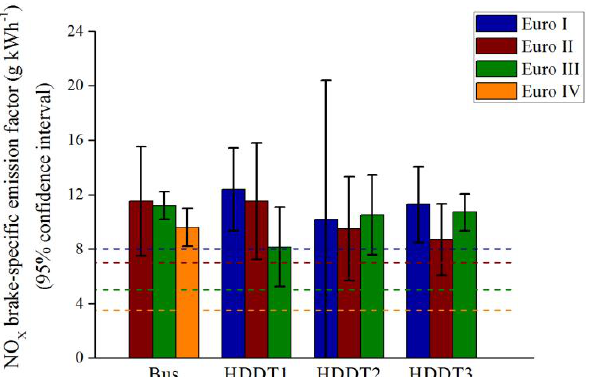
Fig. 8. Estimated brake-specific NO x emission factors for buses un- der a typical driving cycle with an average speed of 18kmh − 1 and trucks under a typical driving cycle with an average speed of 40kmh − 1 . The dotted lines in the figure, which vary in color, in- dicate the emission limits of certification testing for HDDVs from Euro I to Euro